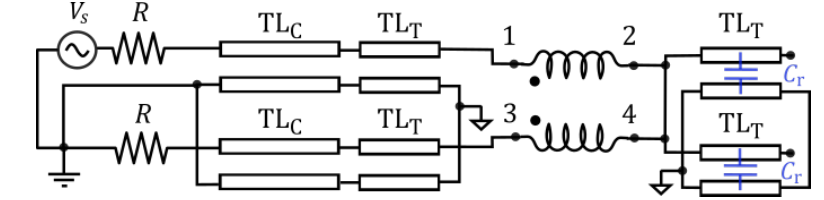
Figure 4. Schematic of a CMC mounted on a grounded PCB connected in UDM setup. Transmission lines labelled as TL C stand for the interconnecting cables. Transmission lines labelled as TL T represent the signal traces of the PCB. The signal traces terminated as open-circuits at terminals 2 and 4 are supposed to be electrically short and thereby modeled as two capacitances C r to